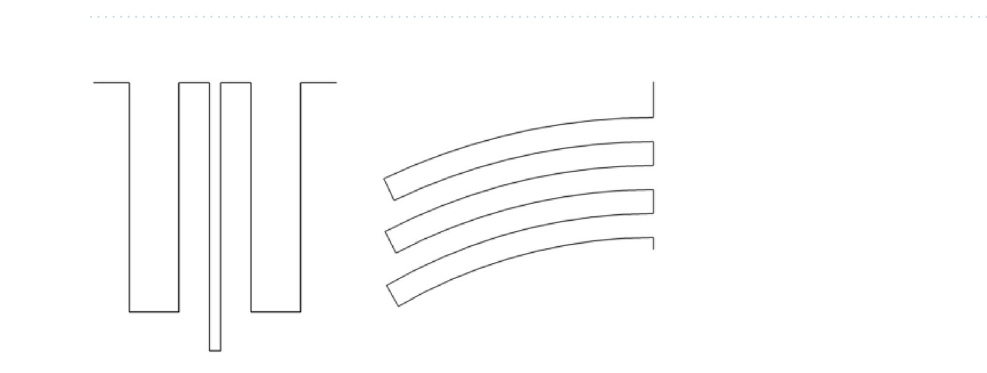
Figure 5. Sensitivity analysis of bandgap width with various cross-sectional area.